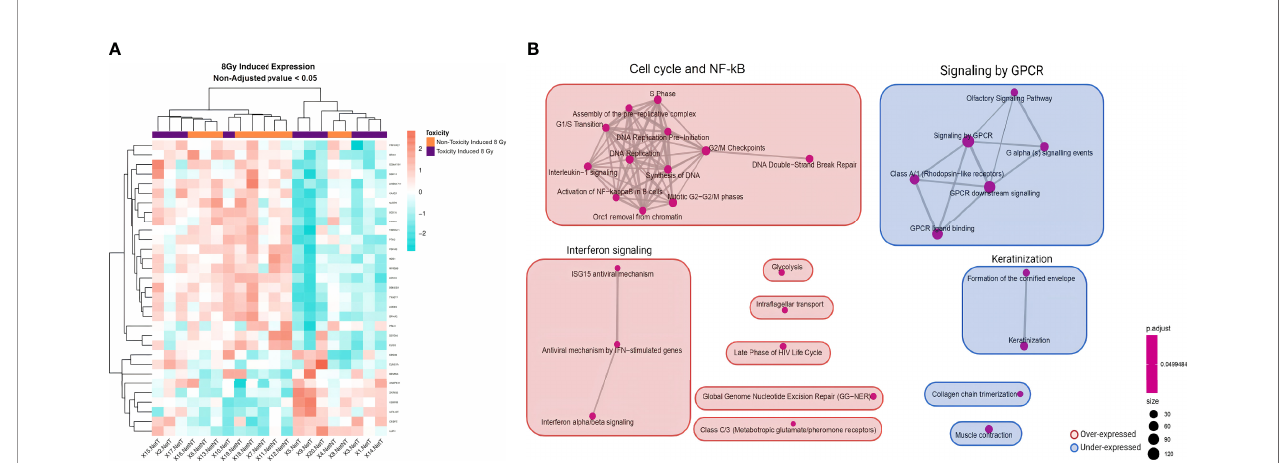
FIGURE 2 | Heatmap and GSEA of 8 Gy-induced expression comparing patients with late skin toxicity to normal responders. (A) A different expression pattern between patients without toxicity (orange) from those with toxicity (purple) of 8 Gy-induced expressed genes with non-adjusted p -value <0.05 is suggested by hierarchical clustering classi fi cation of patients (columns). (B) The enrichment map allows the visualization of the general expression landscape induced by 8 Gy of the toxicity group compared with the non-toxicity group. The key is shown in the bottom right of the fi gure. The map is constructed with an FDR cutoff of <0.05. Each node corresponds to a gene set from the GSEA; its size represents the number of genes in the gene set and its color the p -value. The thickness of the lines connecting the nodes is proportional to the number of genes that overlap in the gene set. Clustering among the various gene sets is visualized with boxes over the nodes. Those sets that are upregulated in patients with toxicity are shown in red and those downregulated are shown in blue. NetT, 8 Gy-induced expression in toxicity patients; NetNT, 8 Gy-induced expression in non-toxicity patients; GSEA, gene set enrichment analysis.